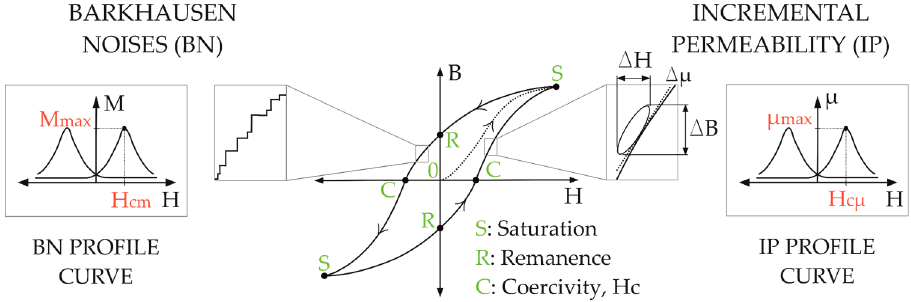
Figure 4. Scheme of hysteresis loop with main parameters of micro-magnetic analysis.